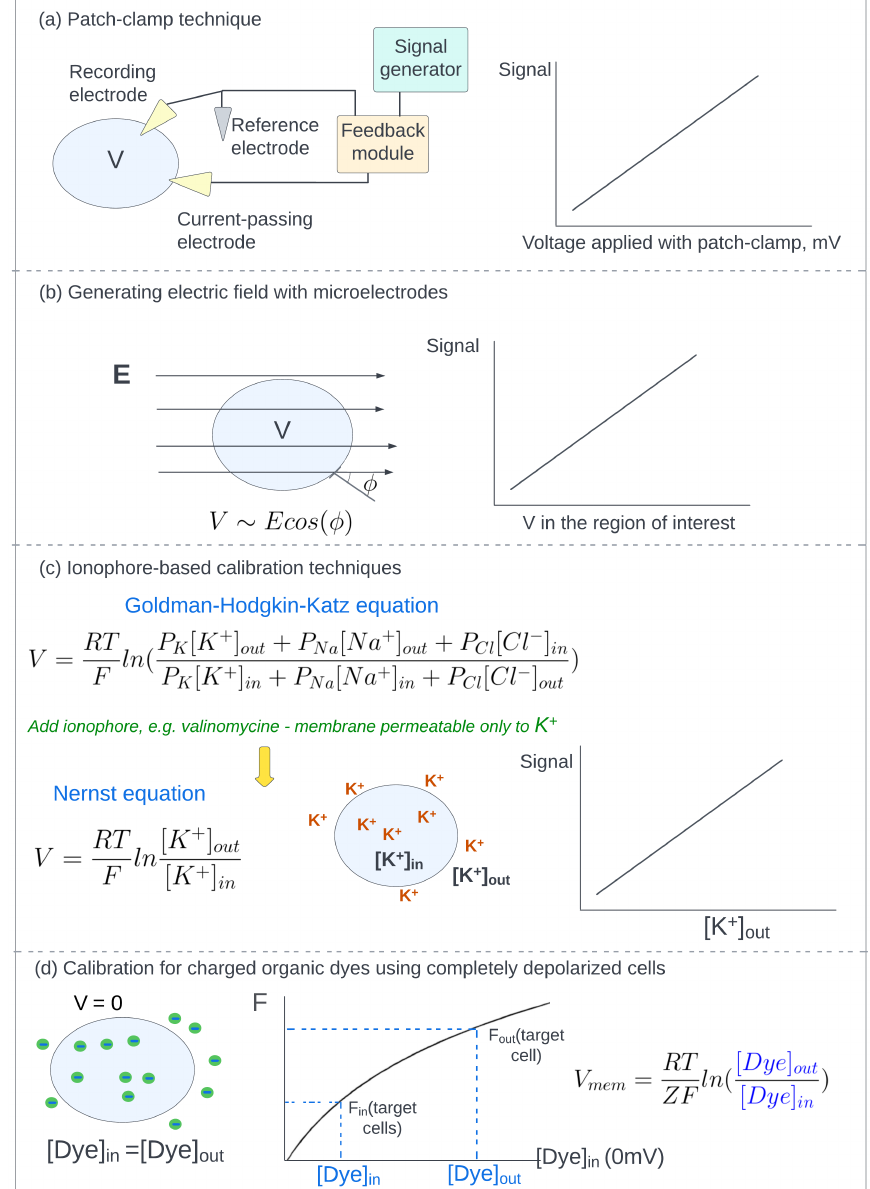
Figure 3. Methods used to calibrate sensors for membrane voltage imaging to measure optical signals for a series of established membrane voltage values. ( a ) Patch-clamp technique. The specific value of cell membrane potential can be established using the patch-clamp device. Actual cell membrane potential is measured as the voltage difference between the recording electrode patched to the cell membrane and the reference electrode placed into an electrolyte or extracellular medium. The value is passed to the feedback module, which determines the difference between the actual and desired values set by a signal generator. The difference is compensated by the injection of an electric current into the cell through the current-passing electrode. ( b ) Generating electric field with microelectrodes. A cell is placed between two microelectrodes that generate a uniform electric field E . The corresponding changes in cell membrane potential are proportional to the